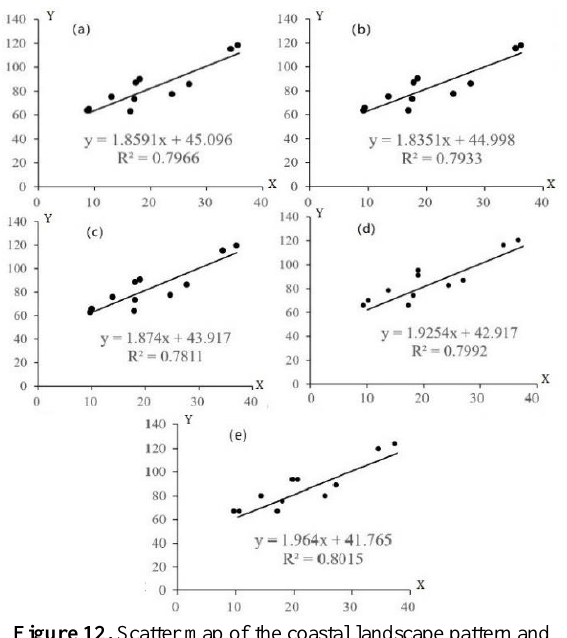
Figure 12. Scatter map of the coastal landscape pattern and luminous radiation, the X axis is the provincial proportion of impervious surface area, and the Y axis is the provincial luminous average value. (a) 2015 (b) 2016 (c) 2017 (d) 2018 (e)